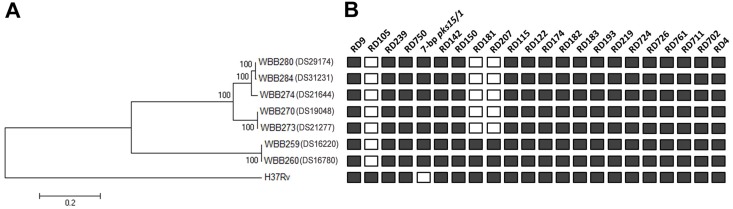
Phylogenetic analysis of serially isolated M. tuberculosis isolates.(A) Phylogenetic tree based on maximum likelihood method using 1,890 high-confidence SNPs and compared to the H37Rv reference genome. The scale bar length represents 0.2 nucleotide substitutions per site. (B) The large sequence polymorphism analysis showing the presence/absence of RDs in each isolate.